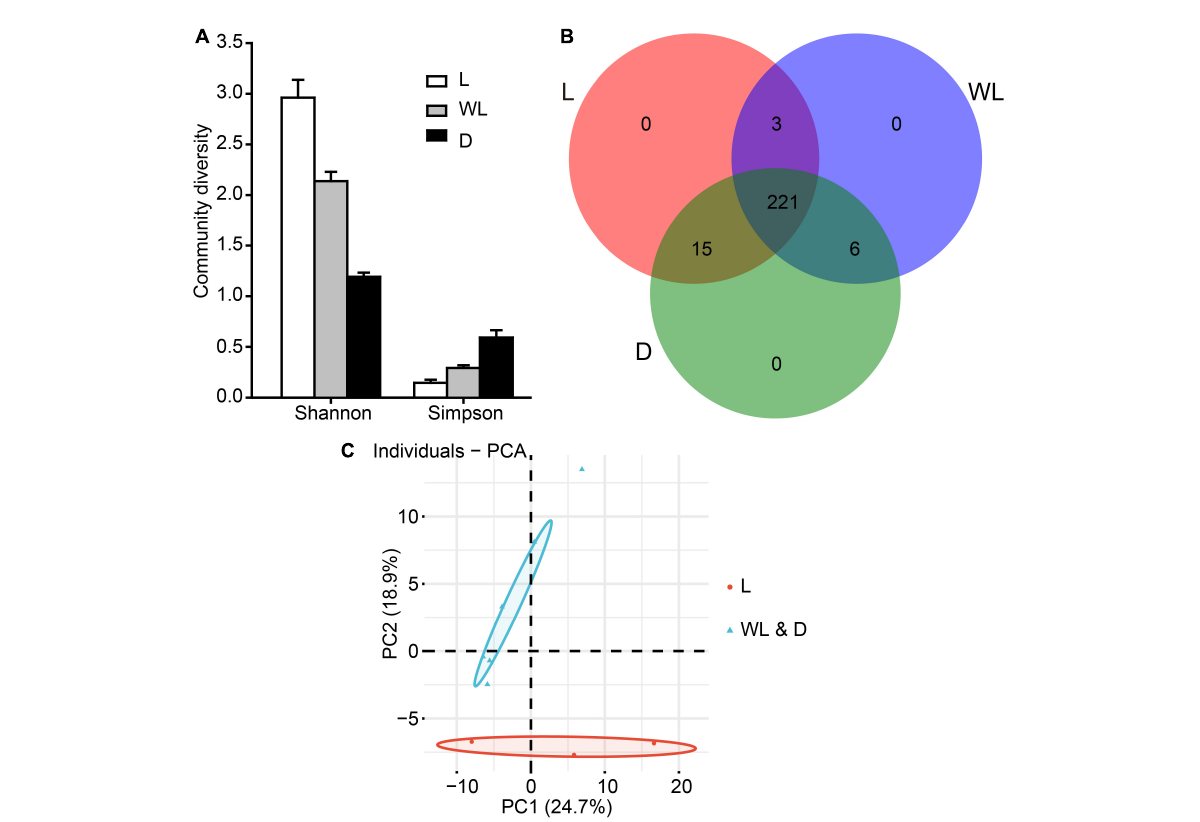
FIGURE2 Gut bacterial community dynamics among different light-strength regions in D. japanica . (A) Community diversity measured by the Shannon index and Simpson index. (B) Overlap of OTUs from different light-strength regions. (C) Principal component analysis showed gut bacteria were clustered into two groups according to light strengths, based on the Adonis testing result ( R = 0.3457, p = 0.049); the different colors show different groups with the boundaries of the 95% confidence ellipses. The red represents the species from weak light and dark